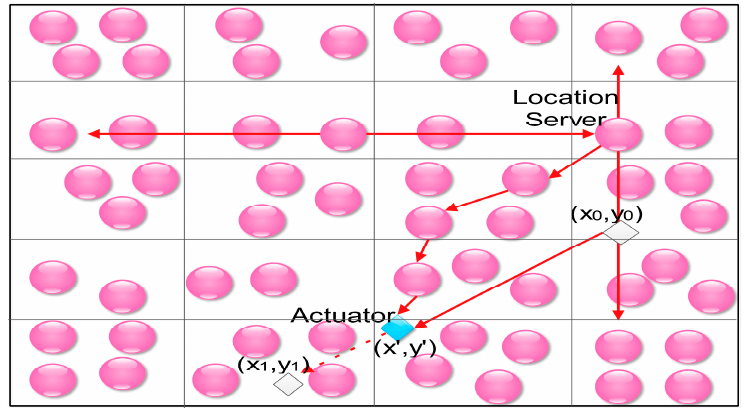
Figure 5. MLS: mobility strategy sharing location service [55].